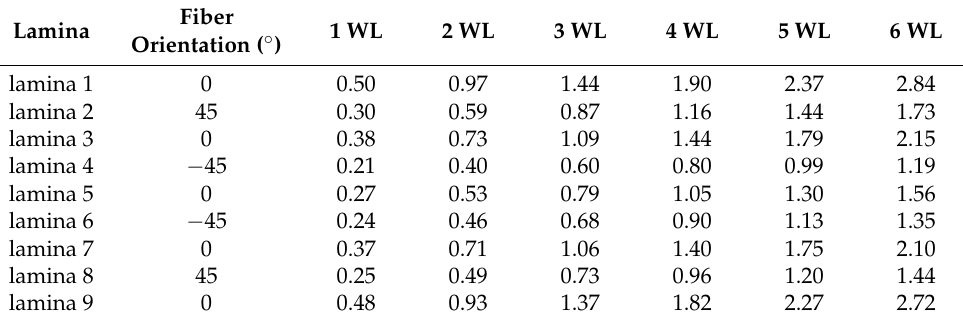
Table 7. Strength ratio with different loads for GFRP composite